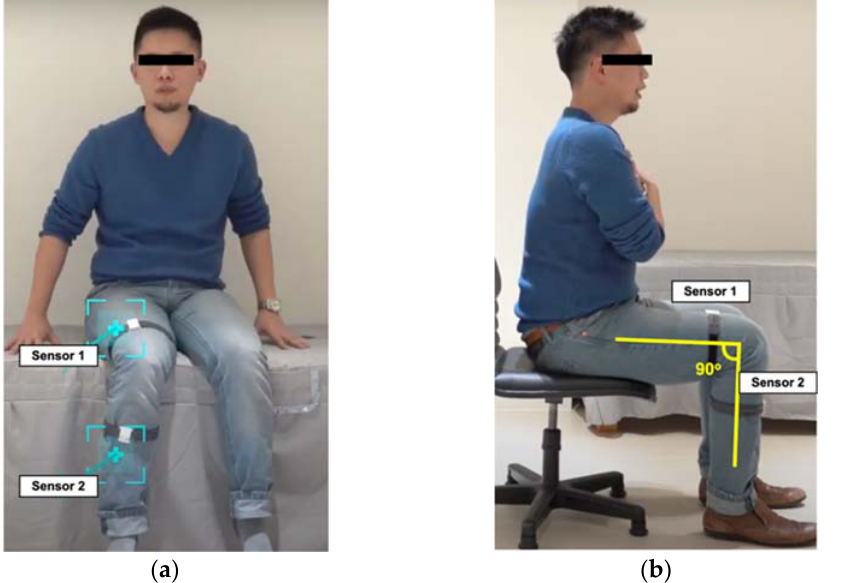
Figure 1. The position of motion sensors worn on the lower limb: ( a ) sensor position; ( b ) calibration position.